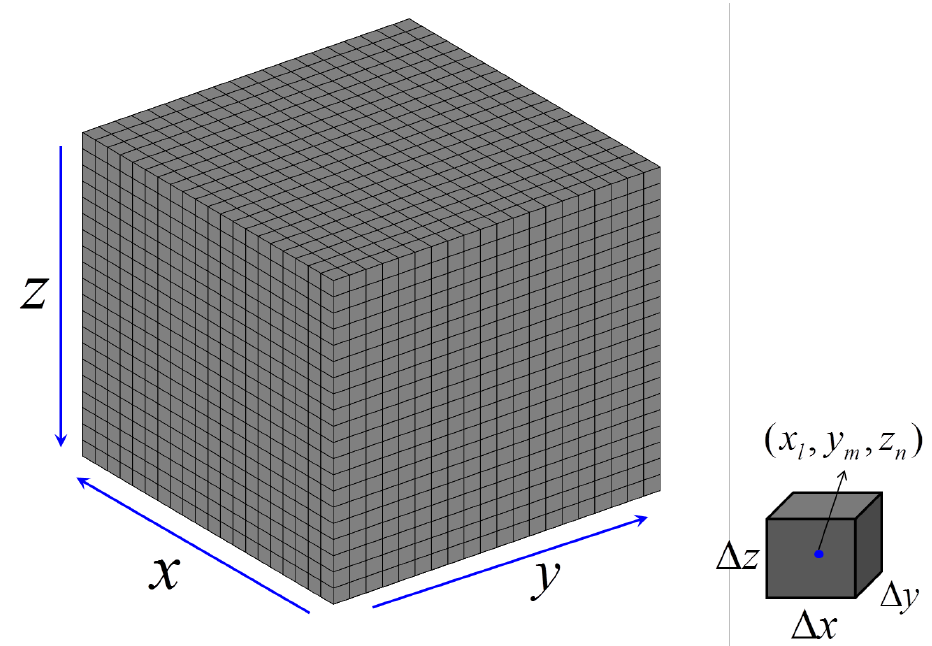
Figure 1. The discretization and coordinate system of the computation space. The observation points are located on the first horizontal plane and have coincident ( x , y , z ) coordinates with the source